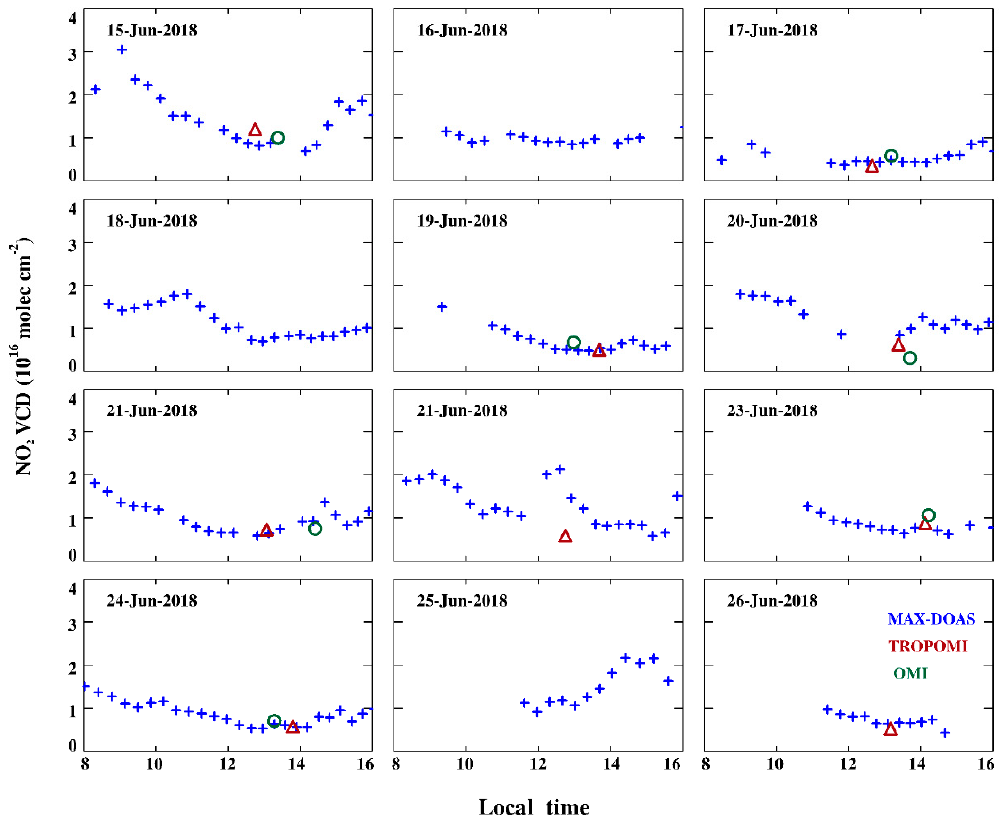
Figure 7. Average diurnal variation of tropospheric NO 2 VCDs measured by MAX-DOAS (plus symbols) during 08:00 to 16:00 local time at Xianghe station. The open triangles and circles denote the TROPOMI75 and OMI measurements for the site, respectively (units: 10 16 molec cm –2 ).